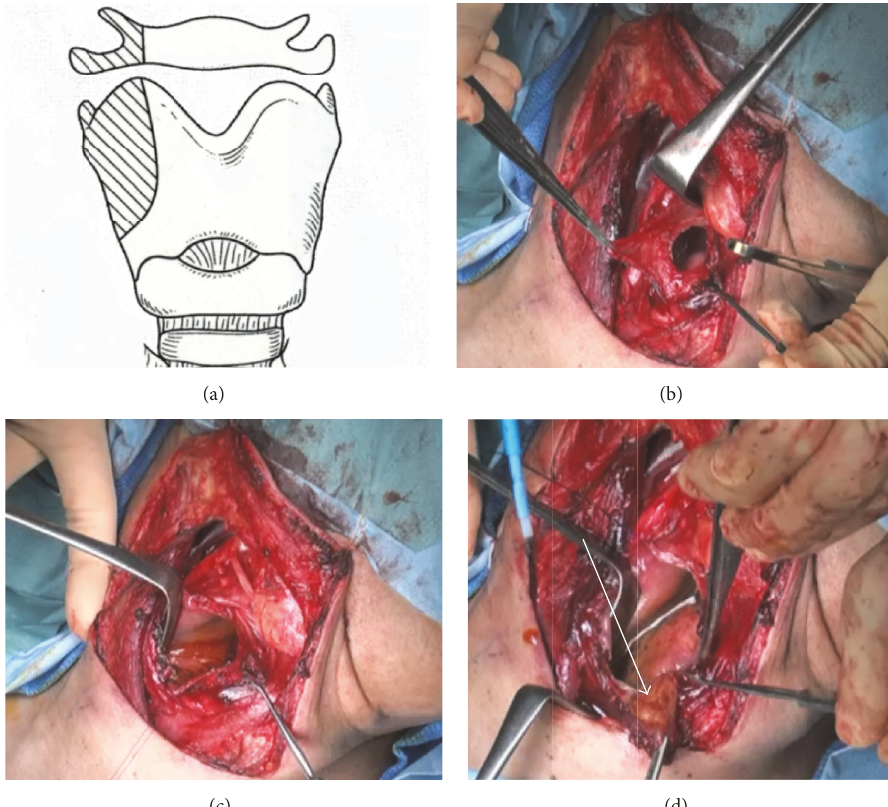
Figure 1: (a) Hyoid bone and laryngeal cartilage were dissected as figure drawings. (b) The tumor was exposed. (c) Lugol’s solution (iodine- glycerin) was used. (d) The tumor was resected with more than 5 mm